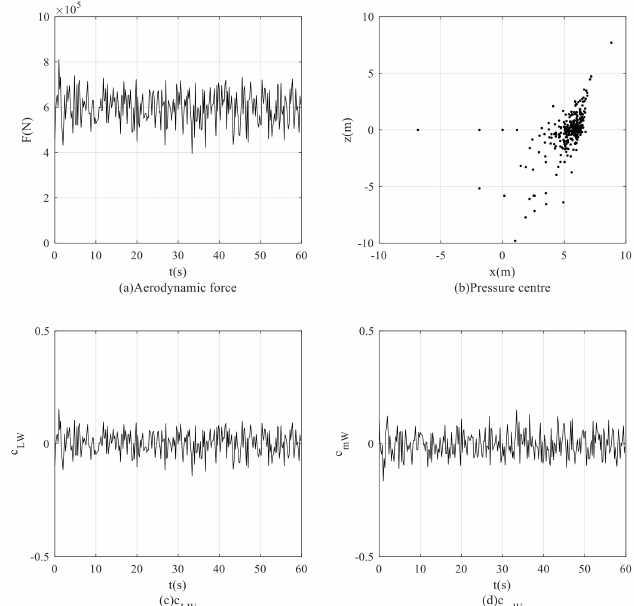
Figure 11. Time-series of vertical wind and acceleration